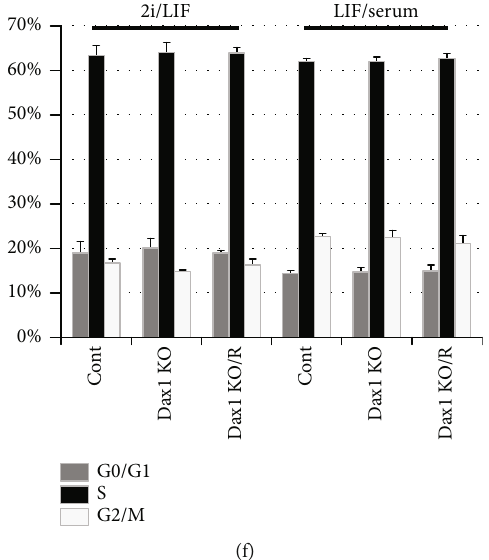
Figure 3: Properties of Dax1KO-ESCs in 2i/LIF and LIF/serum culture. (a) Morphology of colonies formed by the indicated cell lines. Cells were grown in 2i/LIF or LIF/serum for 5 days. Scale bar, 100 μ m. (b) AP staining of colonies formed by the indicated cell lines. Cells were grown in 2i/LIF or LIF/serum for 5 days. Scale bar, 100 μ m. (c) Percentage of colony types formed by cells is shown. Di ff .: di ff erentiated; Undi ff .: undi ff erentiated. (d) Total cell number of the indicated lines cultured for multiple passages. (e) Cell cycle pro fi ling of the indicated cell lines by FACS with propidium iodide (PI) staining and proportions of the cells at each cell cycle were shown in the graph. (f) The apoptosis rate of Dax1KO-ESCs cultured in the indicated conditions. Exponentially growing cells were analyzed for apoptosis using Annexin-V and propidium iodide. Data in (c) – (f) are represented as mean ± s : d : ; n = 3